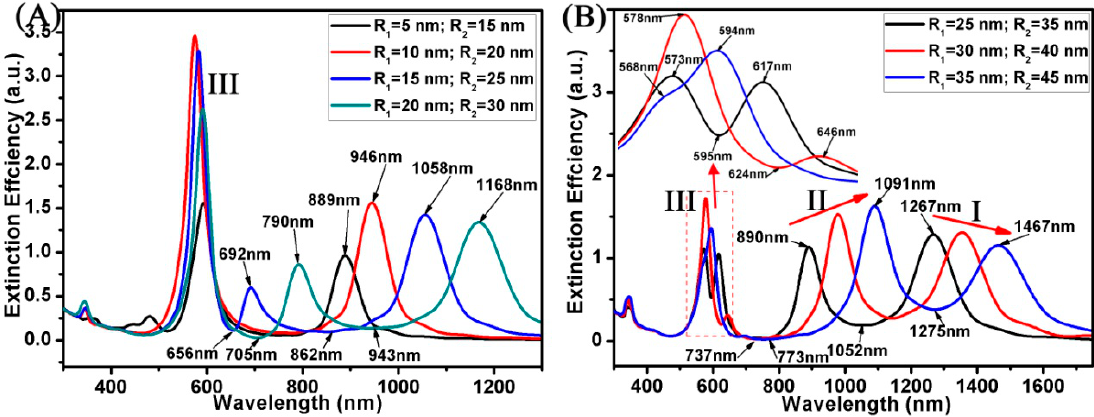
Figure 5. ( A , B ) Spectra calculated for the Au ring ‐ disk nanostructures with different R 1 and R 2 . The R 3 of the disk was unchanged (R 3 = 30 nm). The H of the ring ‐ disk nanostructures was unchanged of the disk was unchanged (R 3 = 30 nm). The H of the ring-disk nanostructures was unchanged (H 1 = H 2 = H = 10 nm). The t of ring was unchanged (t = R 2 − R 1 = 10 nm). (H 1 = H 2 = H = 10 nm). The t of ring was unchanged (t = R 2 − R 1 = 10